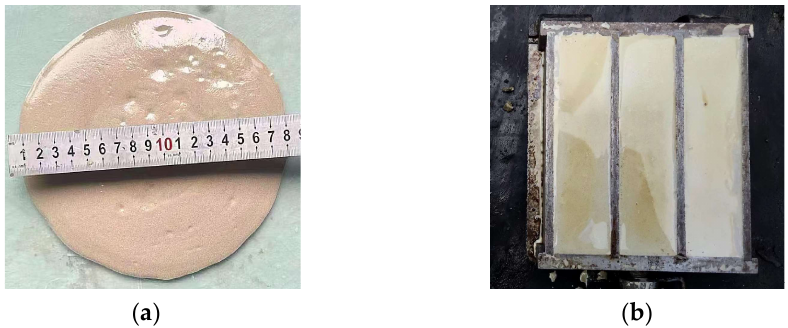
Figure 6. Pre-test of water binder ratio. ( a ) Fluidity; ( b ) Water secretion.